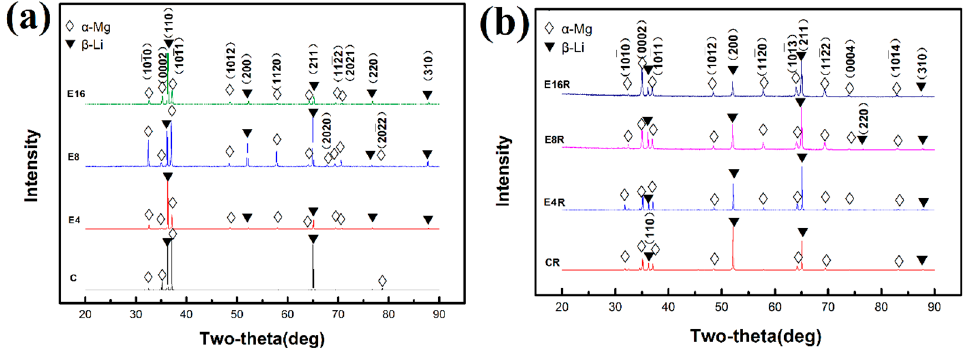
Figure 4. X-ray diffraction patterns of Mg-9Li alloys: ( a ) as-cast and ECAPed alloys; ( b ) rolled alloys.